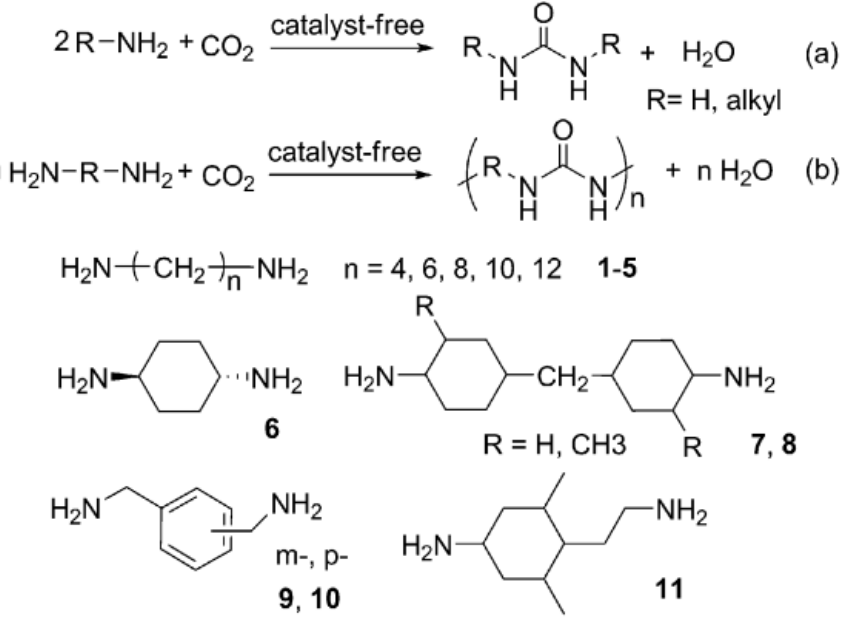
Figure 15. CV measurements of EPU measured in aqueous H 2 SO 4 (1.0 M) at a scan rate of 50 mVs − 1 . From reference [51].